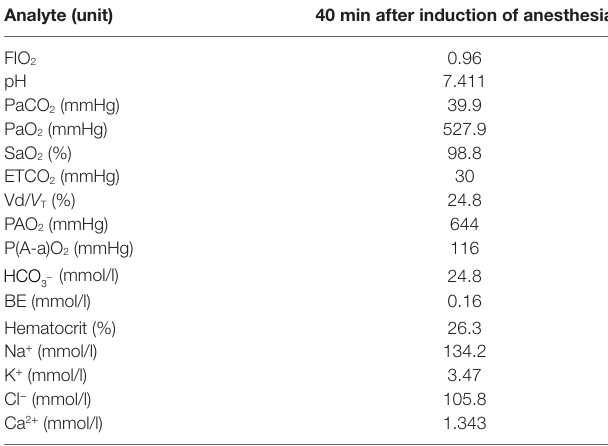
table 2 | Oxygenation, arterial blood gas parameters, and plasma electrolyte concentrations of a 27-year-old female pony under isoflurane anesthesia with volume-controlled ventilation through an orotracheal tube.